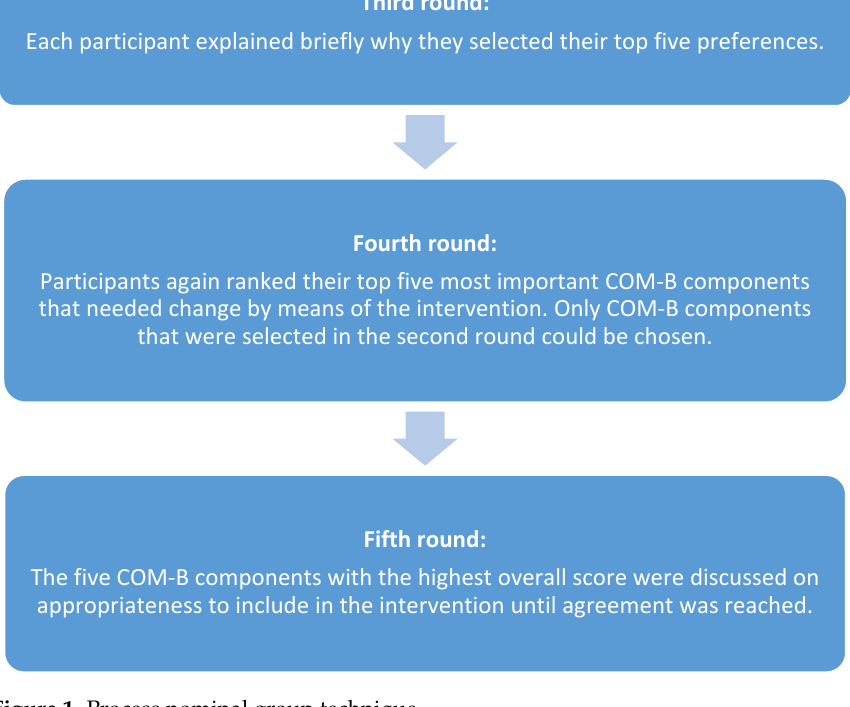
Figure 1. Process nominal group technique.